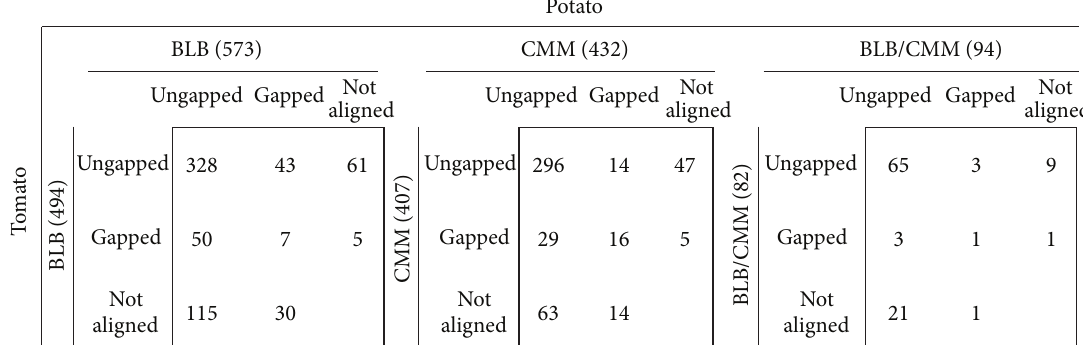
Table 3: Comparison between DArT alignments to potato and tomato genomes. Number of DArT markers aligned along the potato (horizontal) and tomato (vertical) genomes for each collection, given in parenthesis. Each cell, within each matrix, shows the number of DArT markers per alignment type: ungapped, gapped, or not aligned.